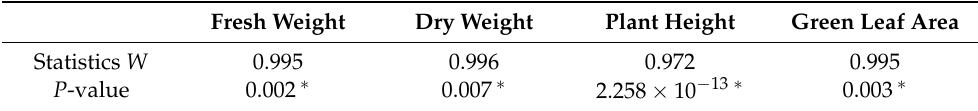
Table 4. Linear regression model residual normality